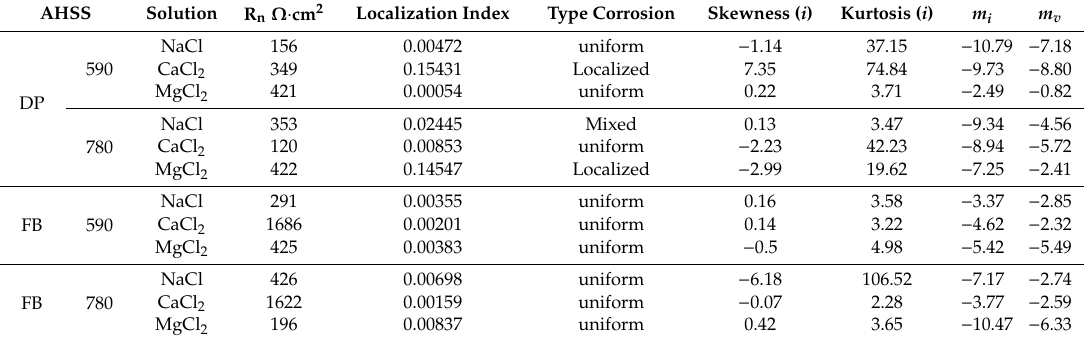
Table 2. Statistical parameters of the noise data of different advances steel in different solutions.